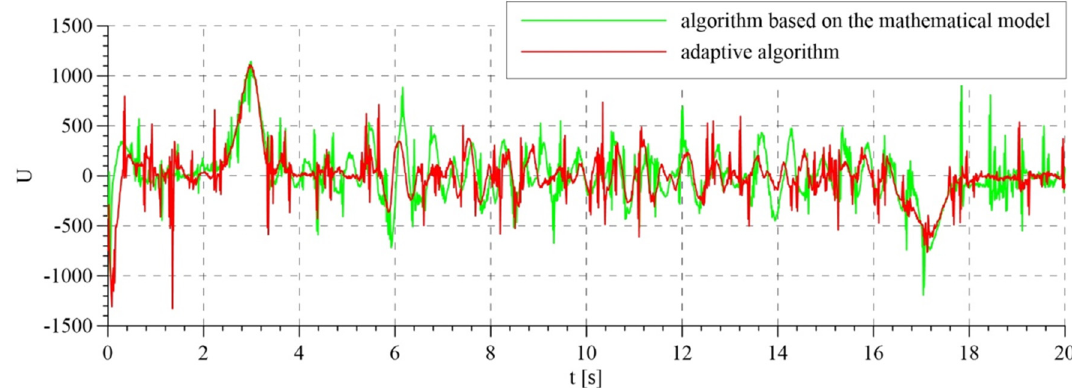
Figure 14. Overall control signals for algorithm based on the mathematical model and for the adaptive algorithm.